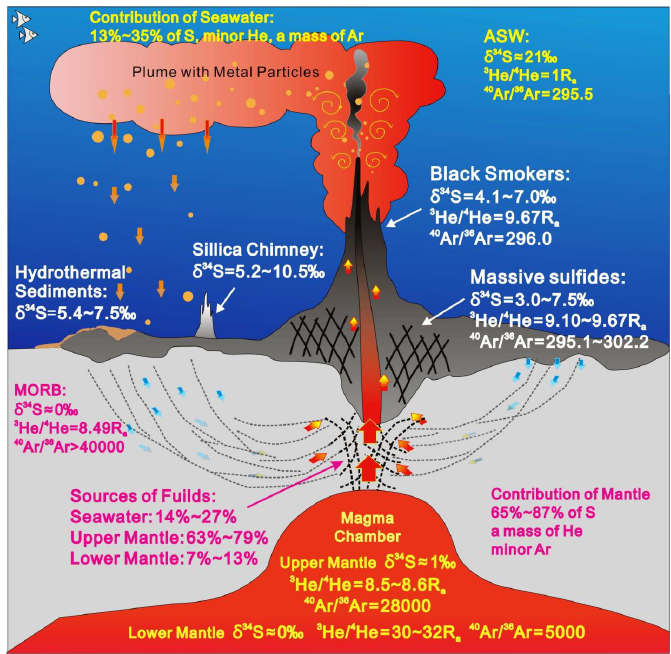
Figure 6. Figure 6. A diagram showing the distribution of He–Ar–S isotopic compositions and their contraints on the proportional contribution of multiple sources to an active hydrothermal vent system located on the ultraslow-spreading Southwest Indian Ridge between 49 ◦ and 51 ◦